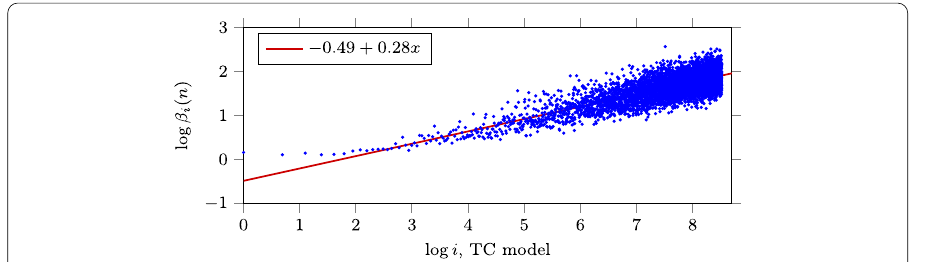
Fig. 15 The scattered log-log plot of points ( log i ,log β i ( n )) , where i is the iteration i = 1, ... ,5000 in which node v i appears and β i ( n ) is its friendship index evaluated at iteration n = 5000 , after simulating TC network of size n = 5000